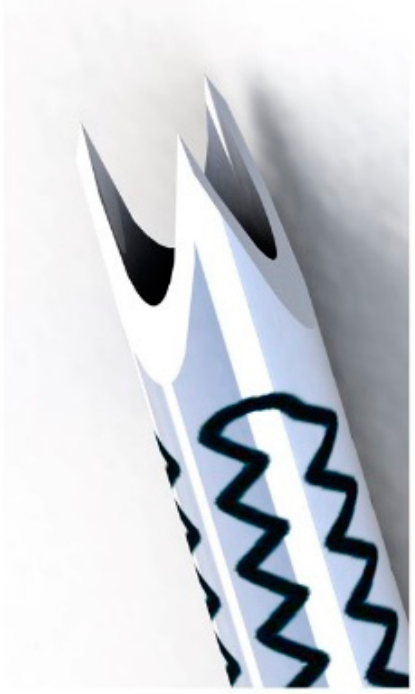
Ⓡ (MediGlobe, Rohrdorf, Germany).